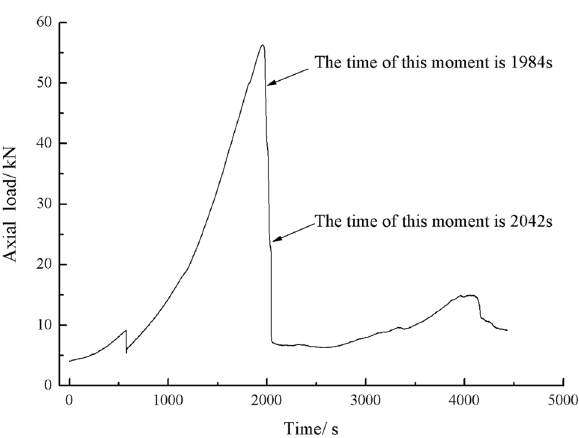
Figure 33. Axial load–time curve for a specimen with 20 mm long cracks. Photographs of this specimen taken at the times marked on the curve are shown as Figs. 34 and 35.